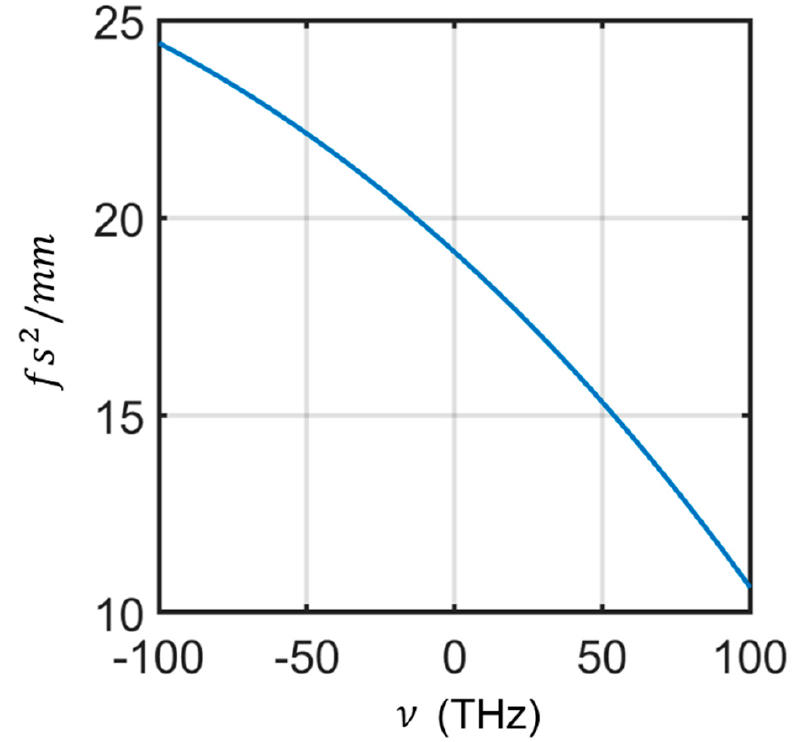
Figure 2. Group velocity dispersion in fs 2 /mm plotted with respect to envelope angular frequencies, across the bandwidth range of interest in an example normal dispersion fiber (Corning hi1060flex). Error in Figure